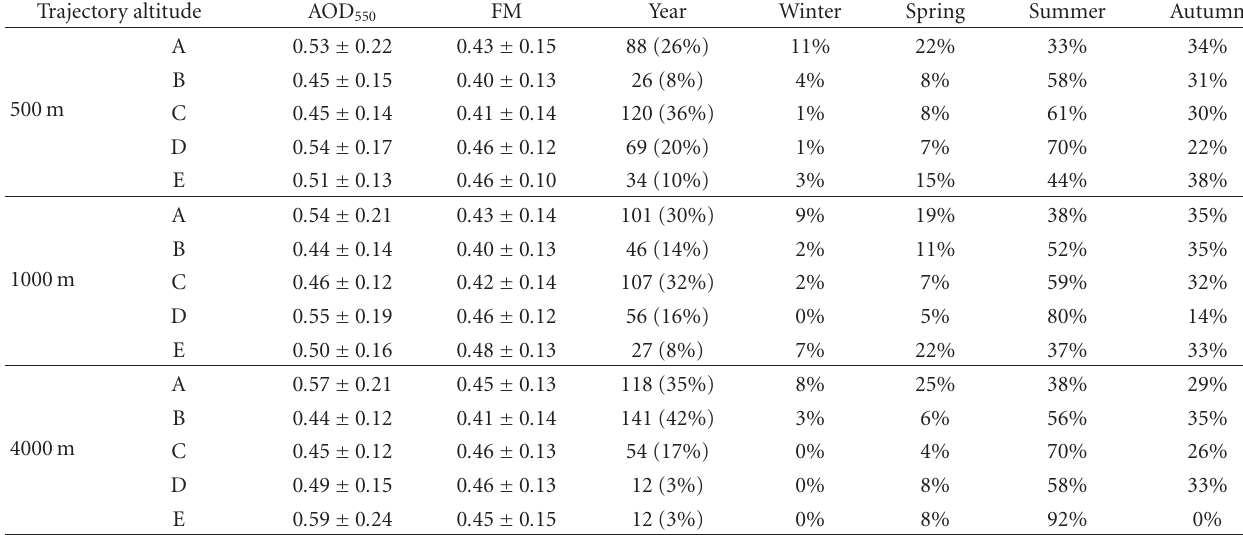
Table 4: As in Table 1, but for the DD